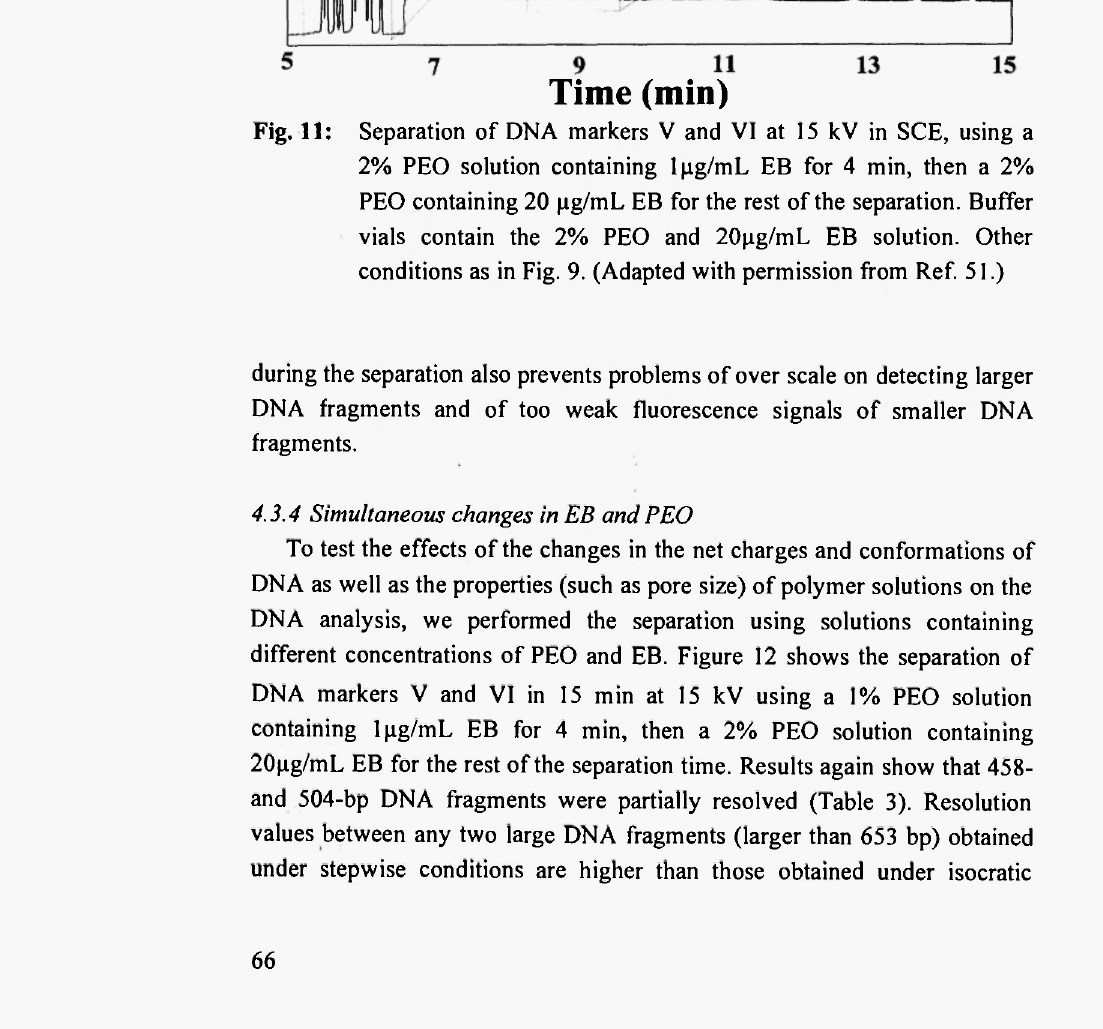
Fig. 11: Separation of DNA markers V and VI at 15 kV in SCE, using a 2% PEO solution containing ^ g / mL EB for 4 min, then a 2% PEO containing 20 μg/mL EB for the rest of the separation. Buffer vials contain the 2% PEO and 2(tyg/mL EB solution. Other conditions as in Fig. 9. (Adapted with permission from Ref.